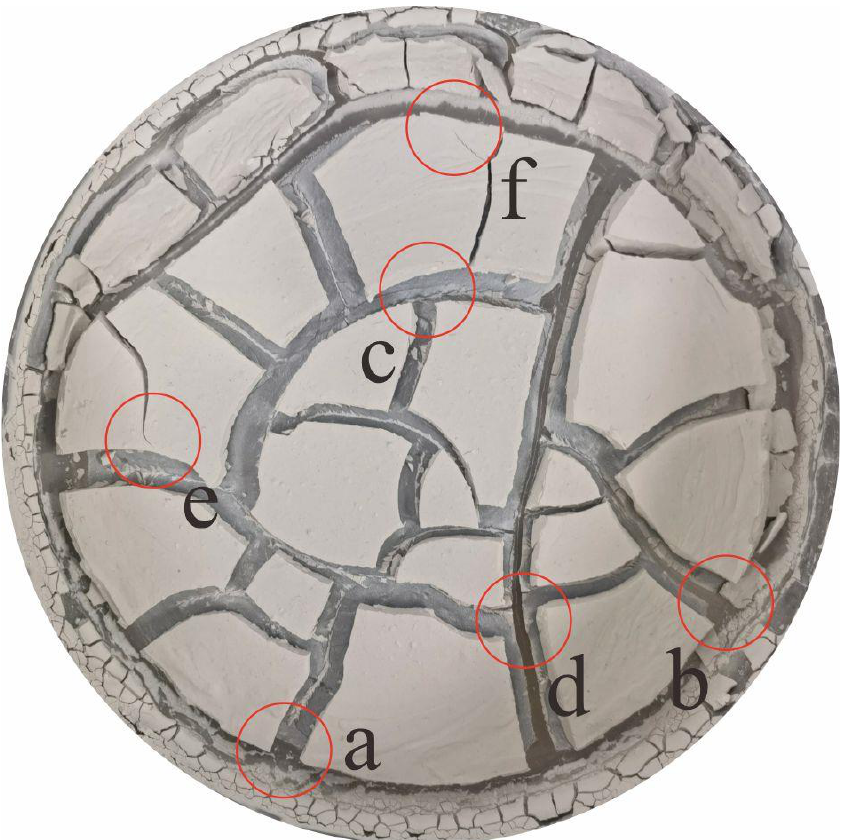
Figure 5. Cracks ended in a variety of places: a, b. Termination at the boundary; c, d. Termination at the intersection with another crack; e, f. They were unaffected by the boundary and other cracks and ended their extension on their own. (The diameter of the sample is 24 cm).